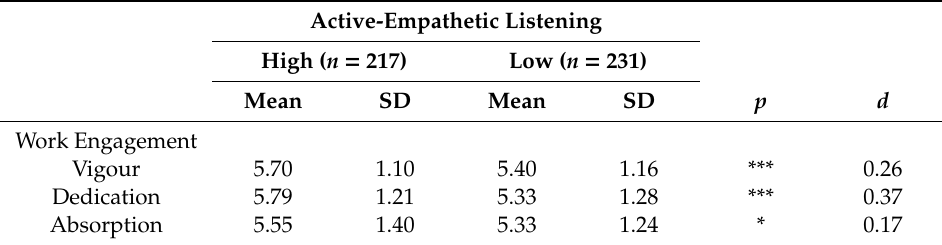
Table 4. Work engagement dimensions and high / low-skilled active-empathetic